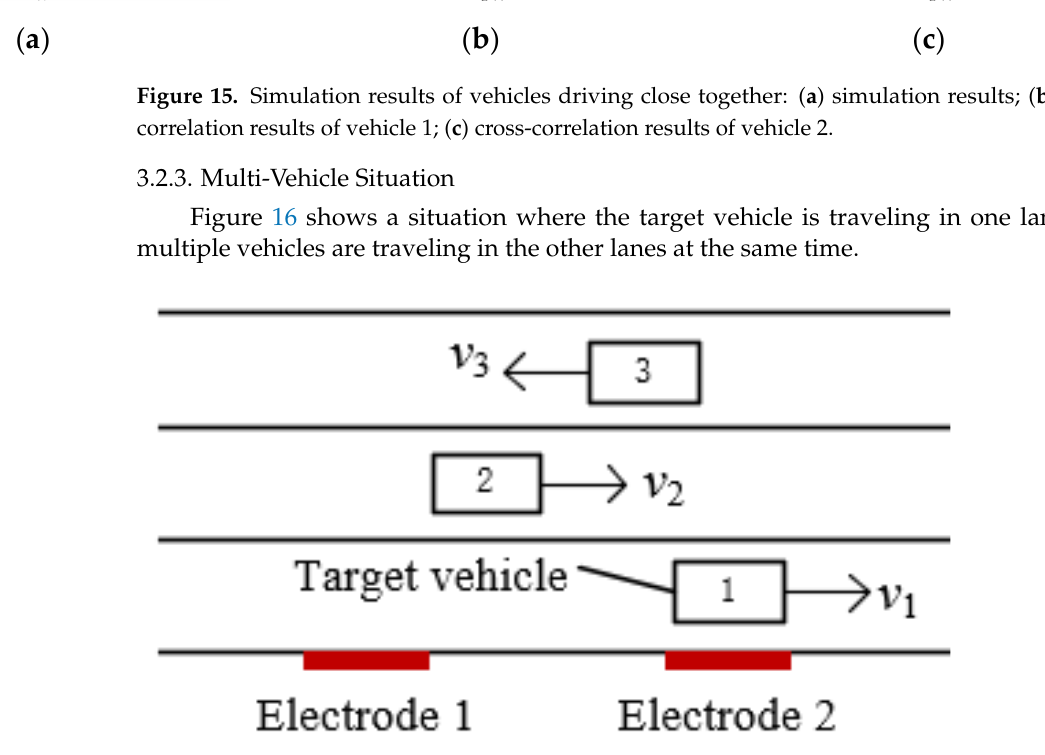
Figure 15. Simulation results of vehicles driving close together: ( a ) simulation results; ( b ) cross-cor- relation results of vehicle 1; ( c ) cross-correlation results of vehicle 2.